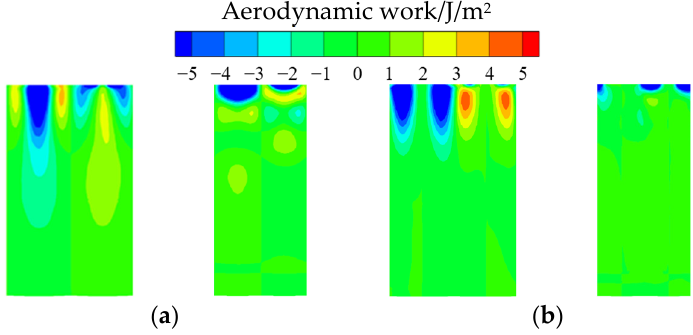
Figure 7. Aerodynamic work distribution: ( a ) First mode; ( b ) Second mode.